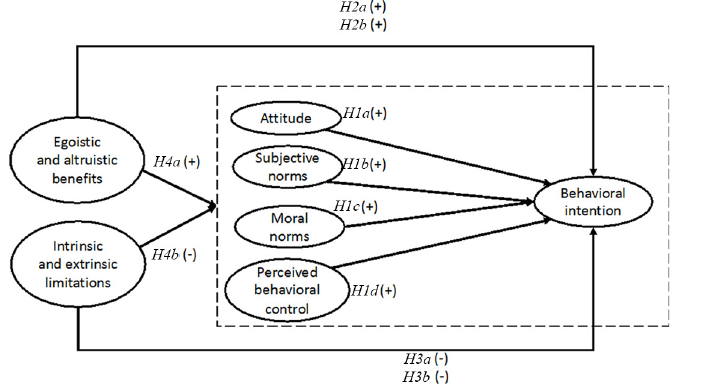
Figure 1. Proposed model